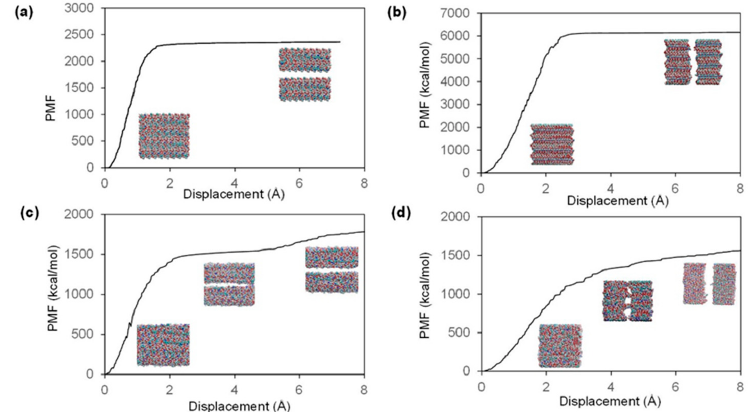
Figure 3 . PMF profiles for each pulling scenario. The “Savitzky–Golay filter” method is adopted to draw a smooth curve by fitting a cubic function for every 100 raw data points. The VMD snapshots show the corresponding pulling situations. ( a , b ) are PMF profiles for chitin model pulling along inter-chain and inter-sheet directions respectively; ( c , d ) are PMF profiles for 85% chitosan model pulling along inter-chain and inter-sheet directions,